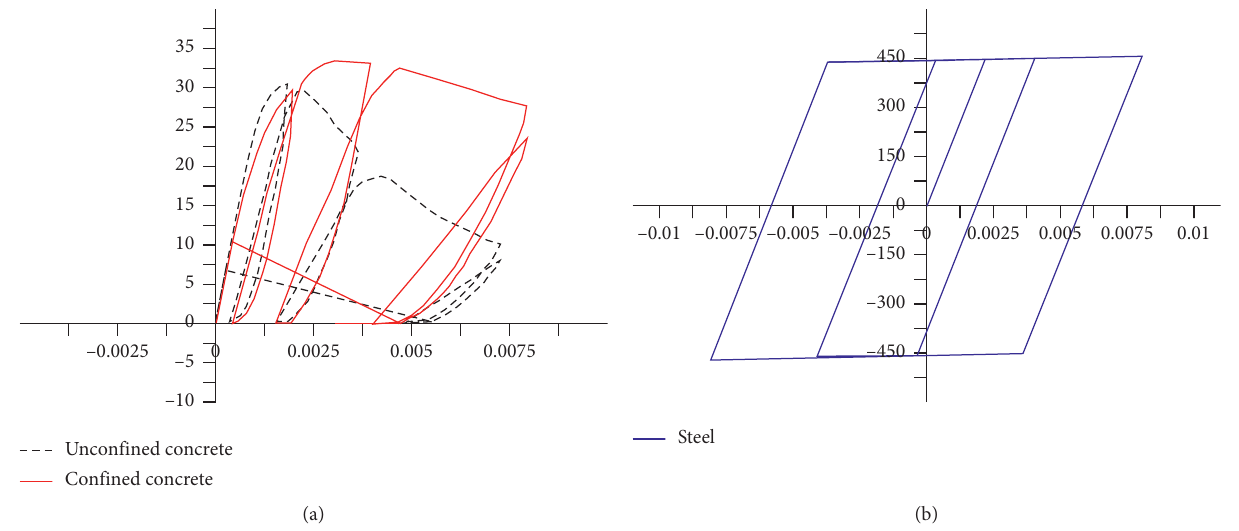
Figure 4: Stress-strain laws used for the analyses. Concrete (a) and steel reinforcement